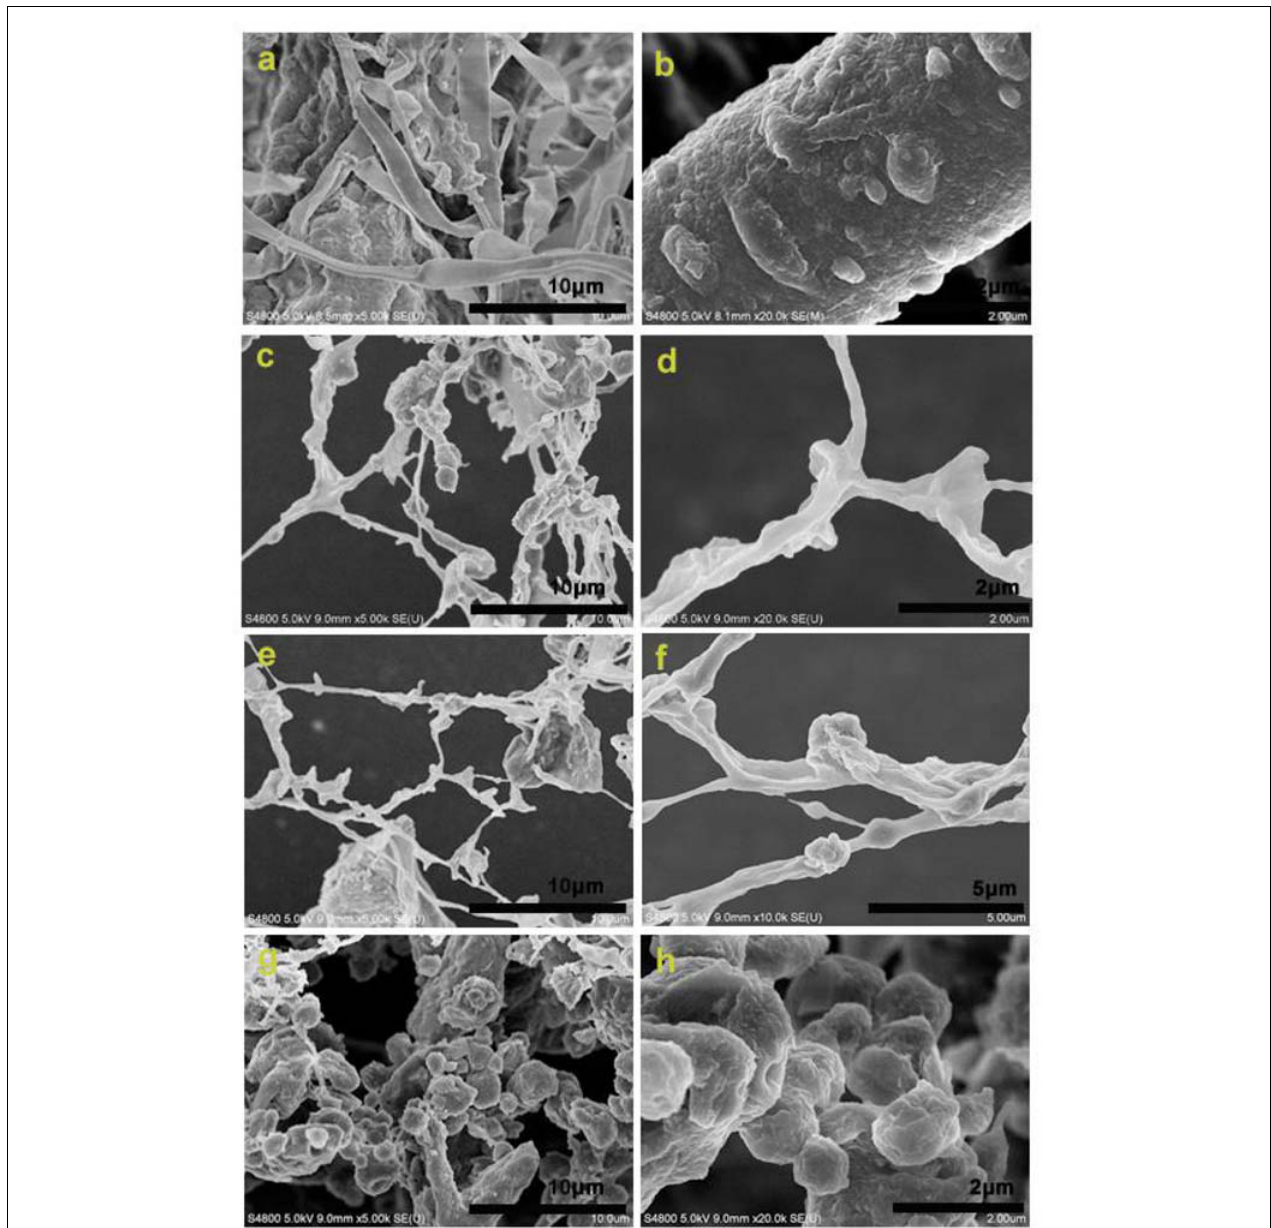
FIGURE 2 | SEM images of the raw material (a,b) , LCNFss-48 h (c,d) , LCNFs-72 h (e,f) , and LNPs-108 h (g,h)